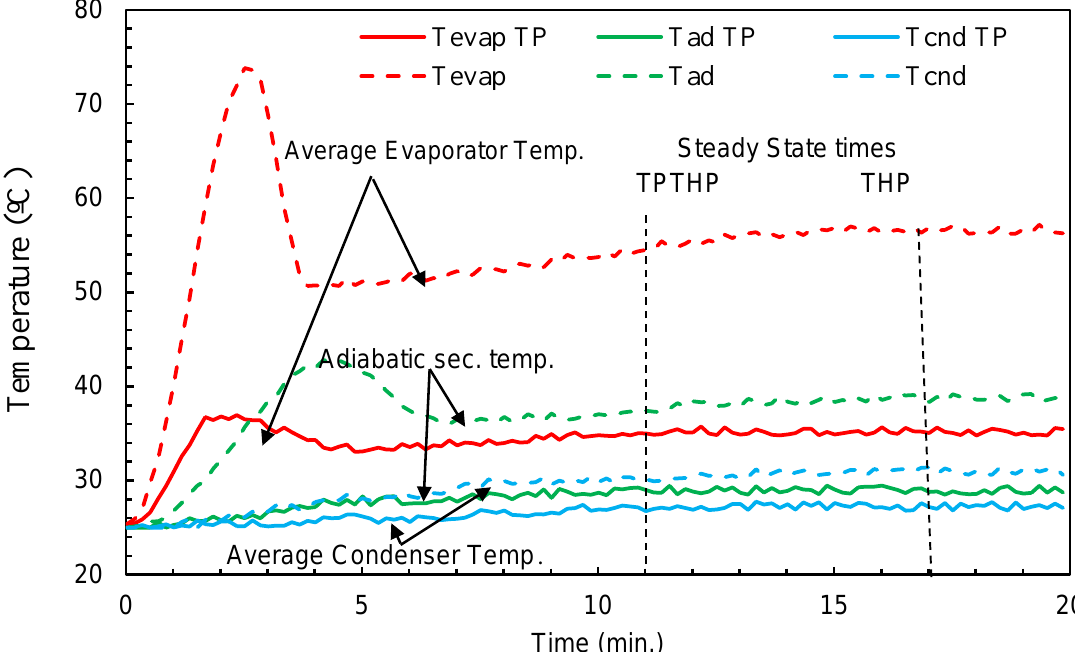
Figure 7. Comparison of experimental transient temperatures evolution of the TPTHP and THP (filling ratio = 50%, inclination angle = 45 ◦ , and input power = 200 W).